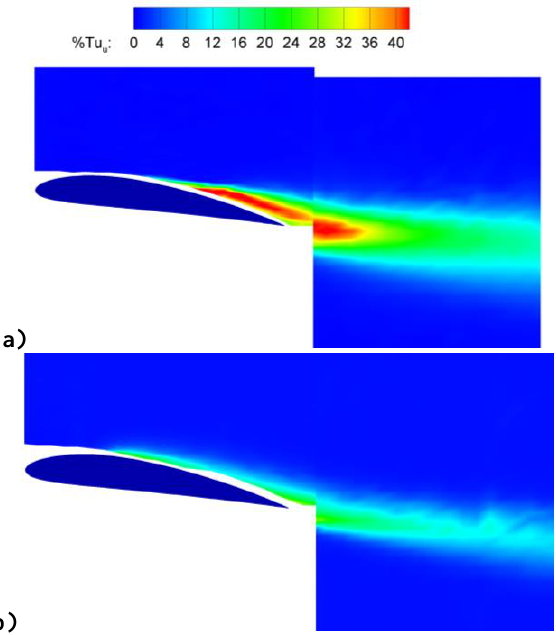
Fig. 8. Turbulence intensity results for Re=5x10 4 , α=8º and z/ s=0.4 a) uncontrolled case, b) partially flexible